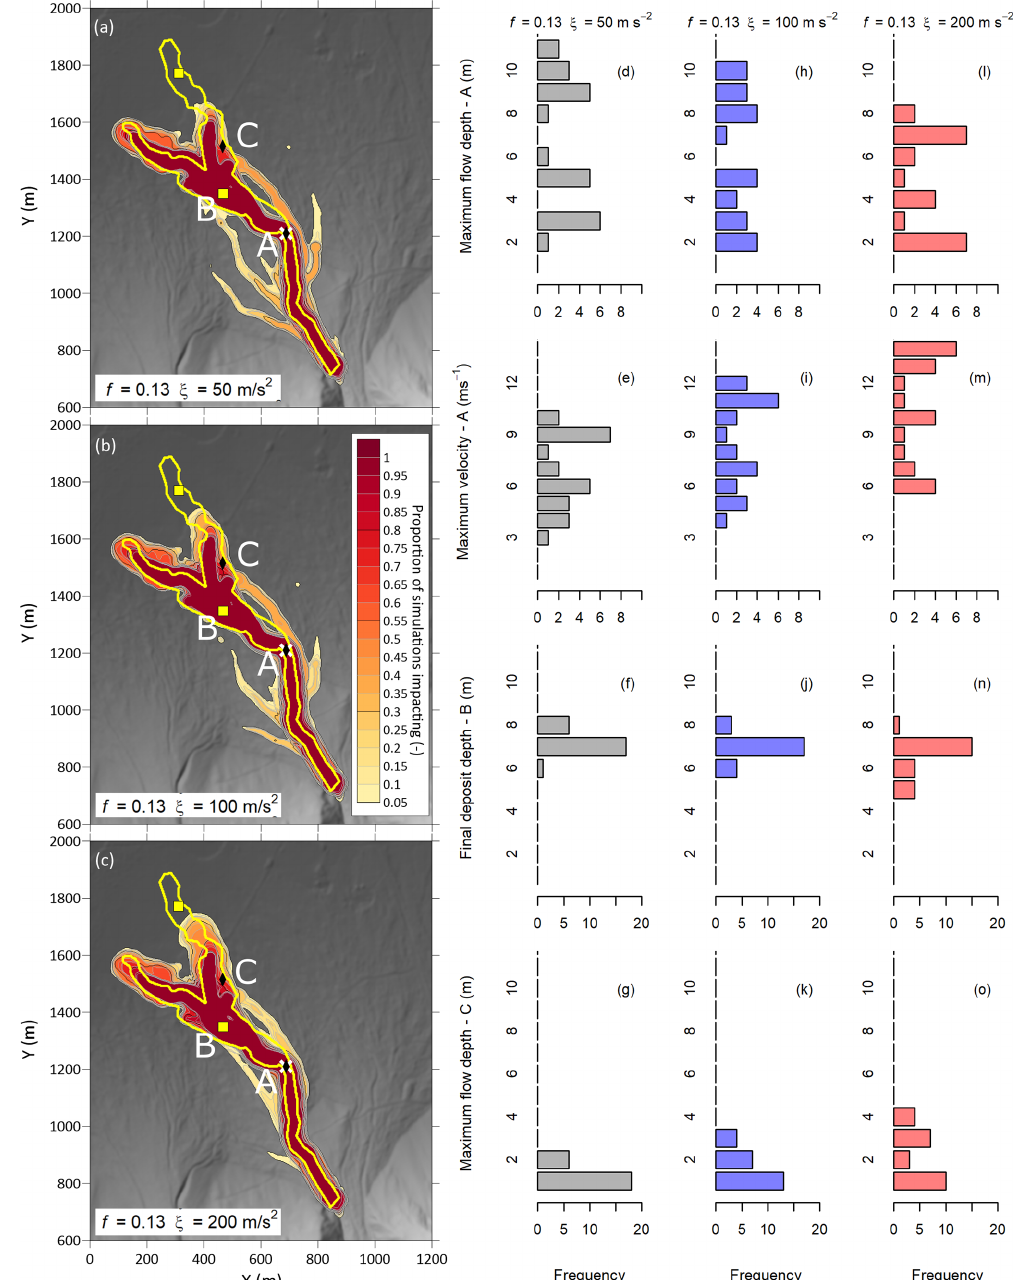
Figure 12. Variability in impact (a–c) and intensity (d–o) using 24 real hydrographs and three sets of Voellmy parameters. Topographic data derived from pre-event (2017) lidar data provided by the Squamish-Lillooet Regional District. The yellow outline on the impact proportion plots (a–c) indicates the observed impact area from the actual